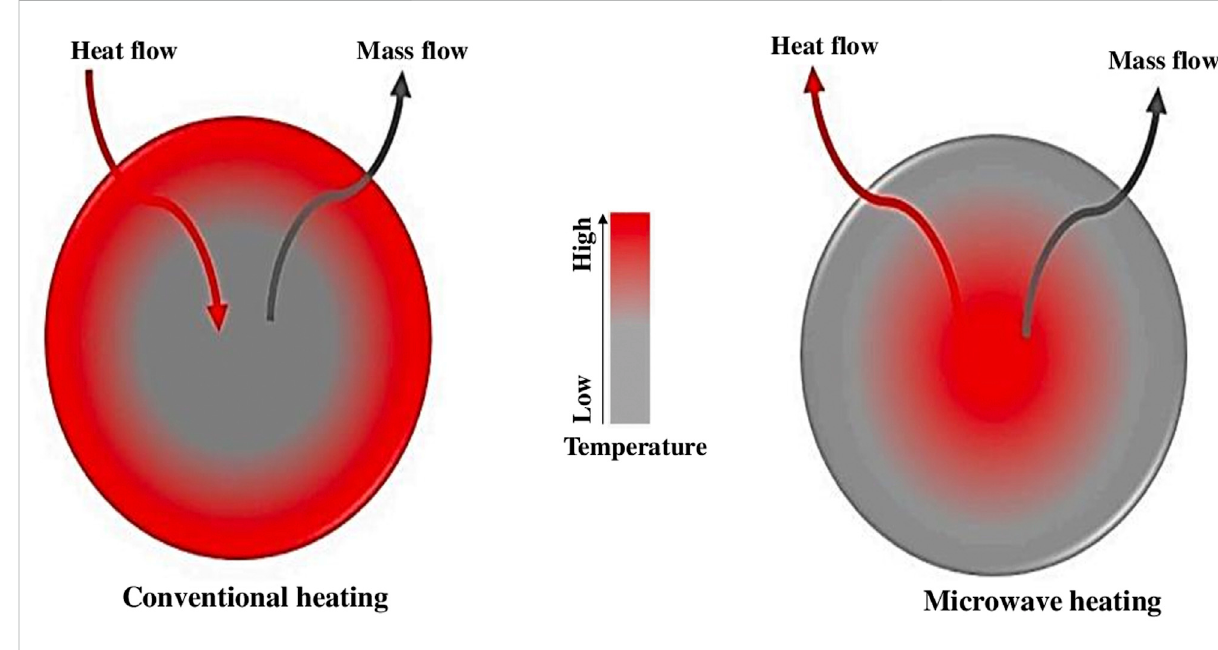
FIGURE 2 Comparison between conventional and microwave heating methods [98].